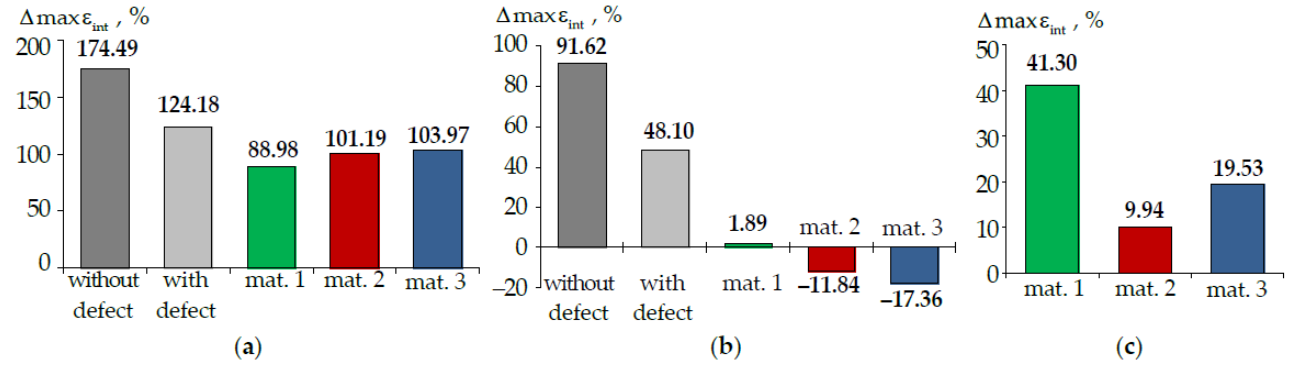
Figure 14. ∆ max ε int : ( a ) is enamel; ( b ) is dentine; ( c ) is inlay; dark-grey is model without defect; light-grey is model with defect; green is model with material 1 inlay, red is model with material 2 inlay, blue is model with material 3